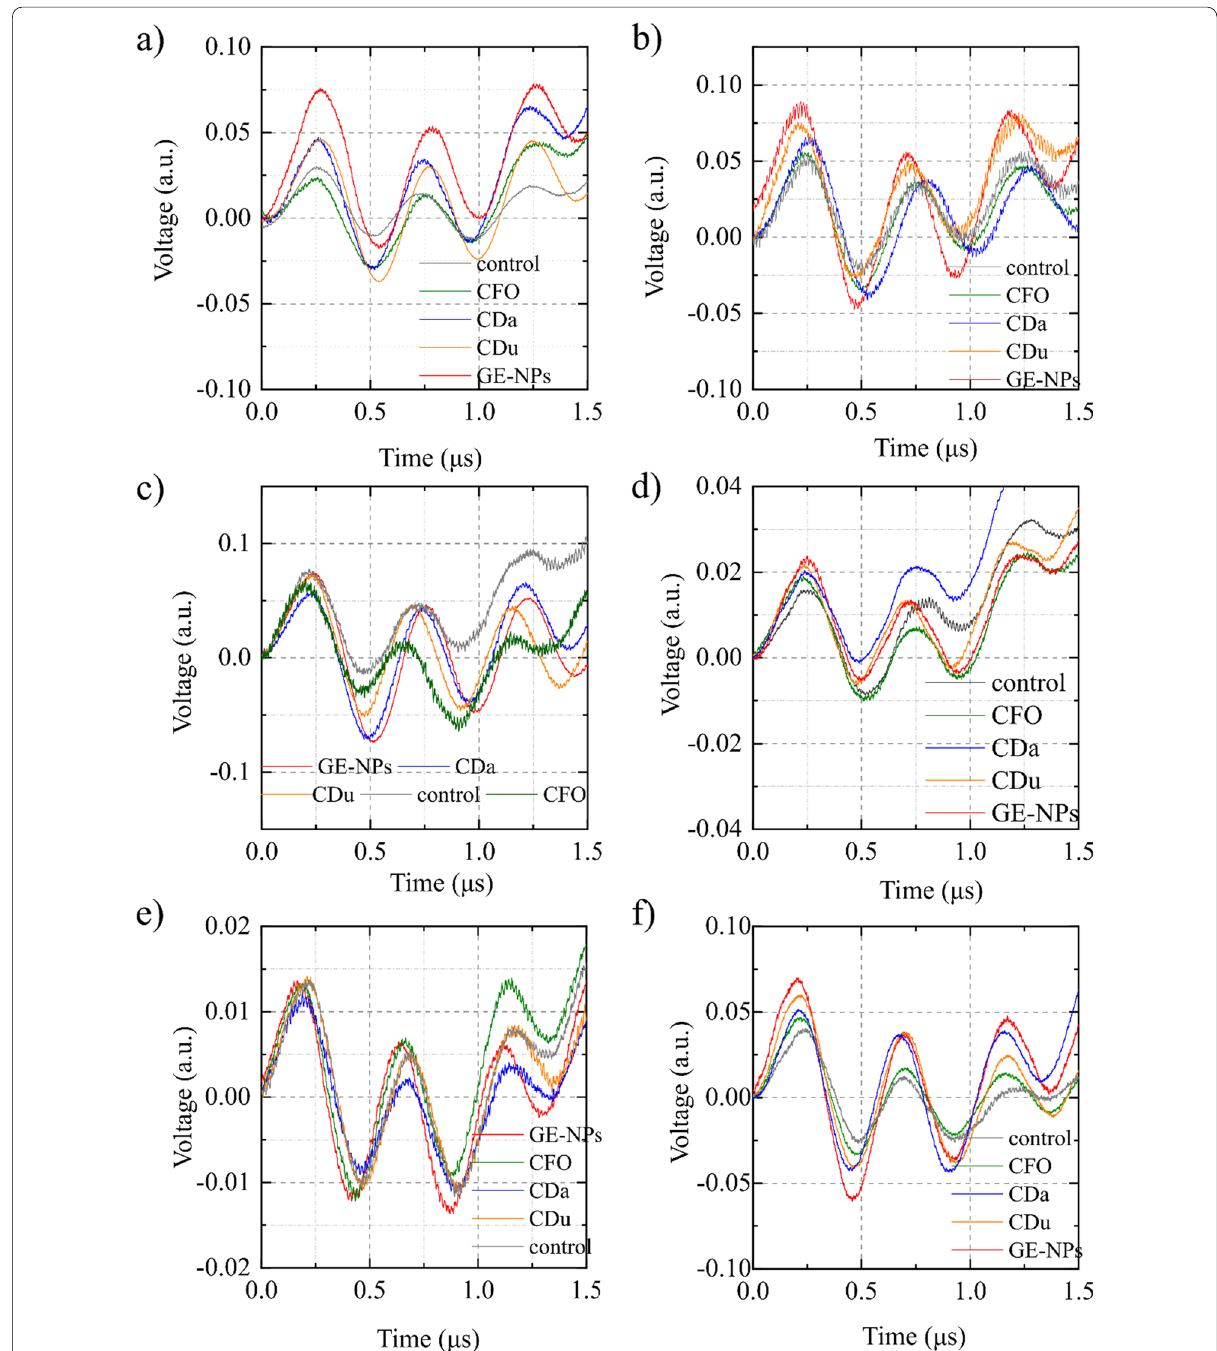
Fig. 4 Photoacoustic responses recorded on a liver, b spleen, c heart, d gastrocnemius muscle samples, e lungs, f kidney. Con: control, CFO: carbon flurooxide nanoparticles; Cda: carbon nanodots from β -alanine; Cdu: carbon nanodots from urea-citric acid; GE-NPs: glucose-ethylenediamine